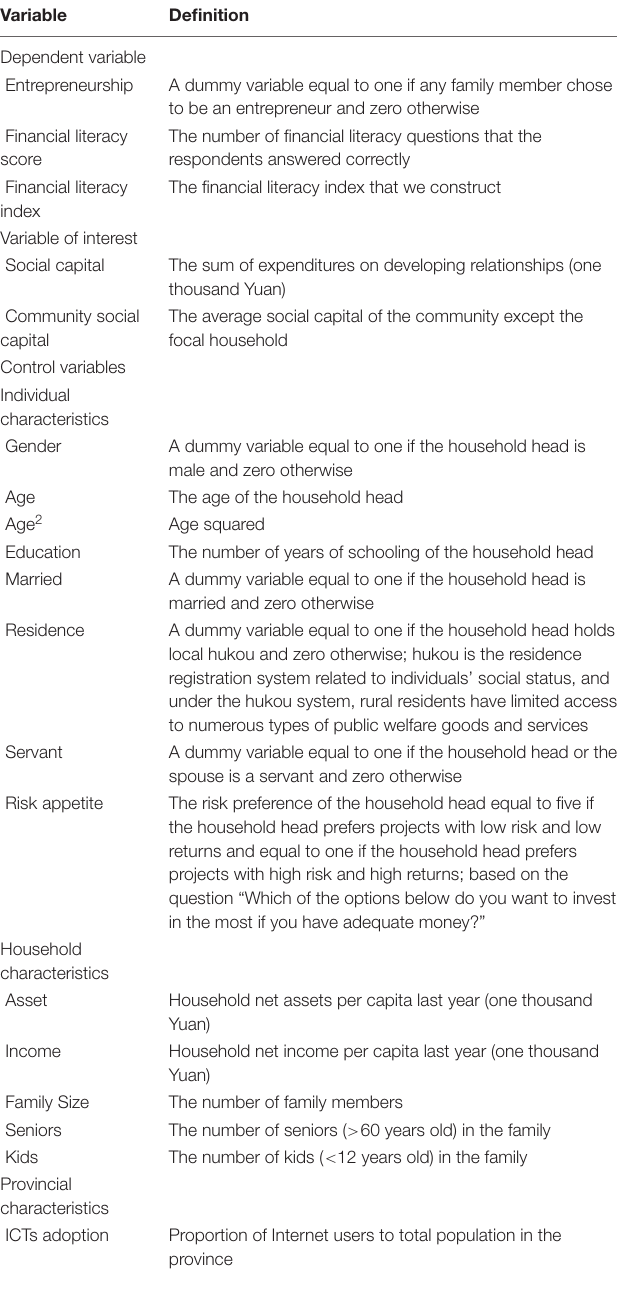
TABLE 3 | Variable definitions, 2015 CHFS